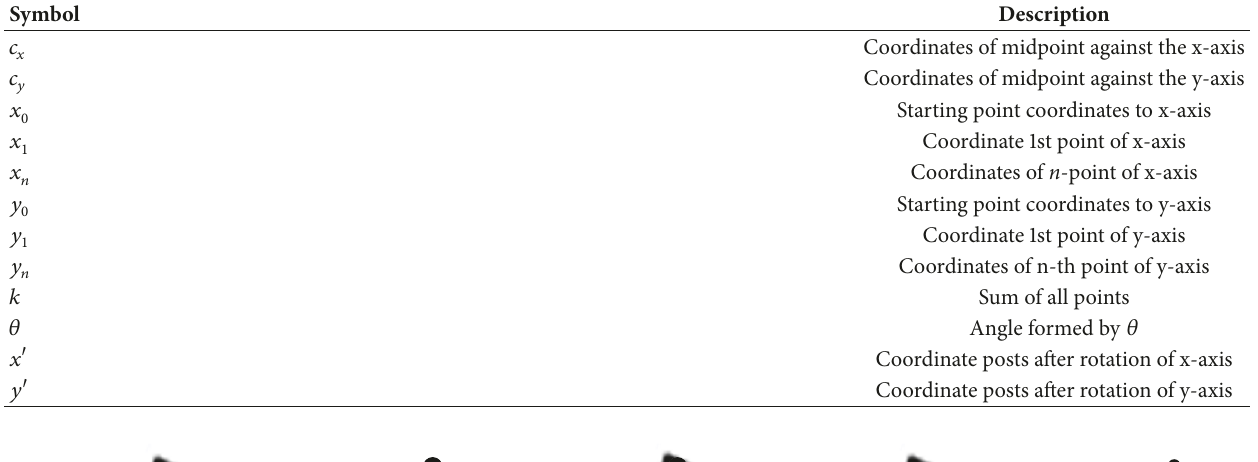
Table 6: Description of Formula Rotation.